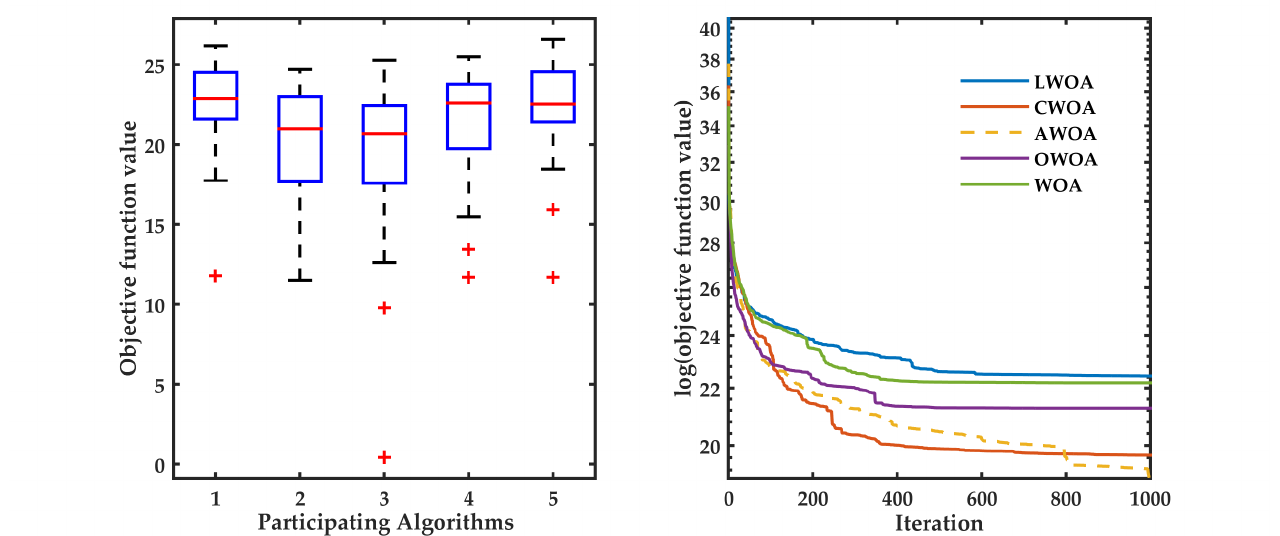
Figure 16. Boxplot and Convergence Property analysis for the FM